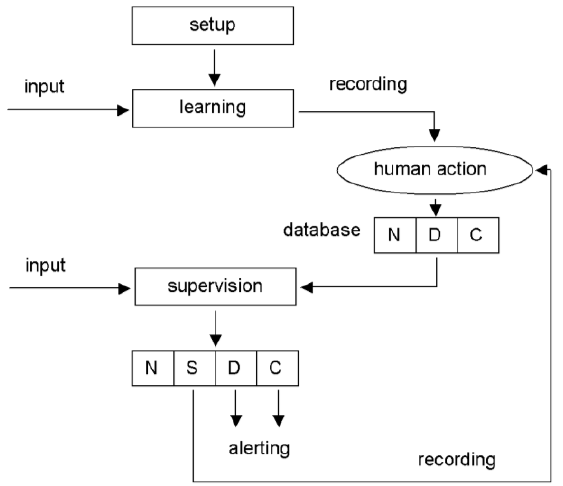
Figure 7. Block diagram of the life cycle of the assisted living system. Abbreviations ―N‖, ―S‖, ―D‖ and ―C‖ stand for following categories of subject behavior: normal, suspicious, dangerous and